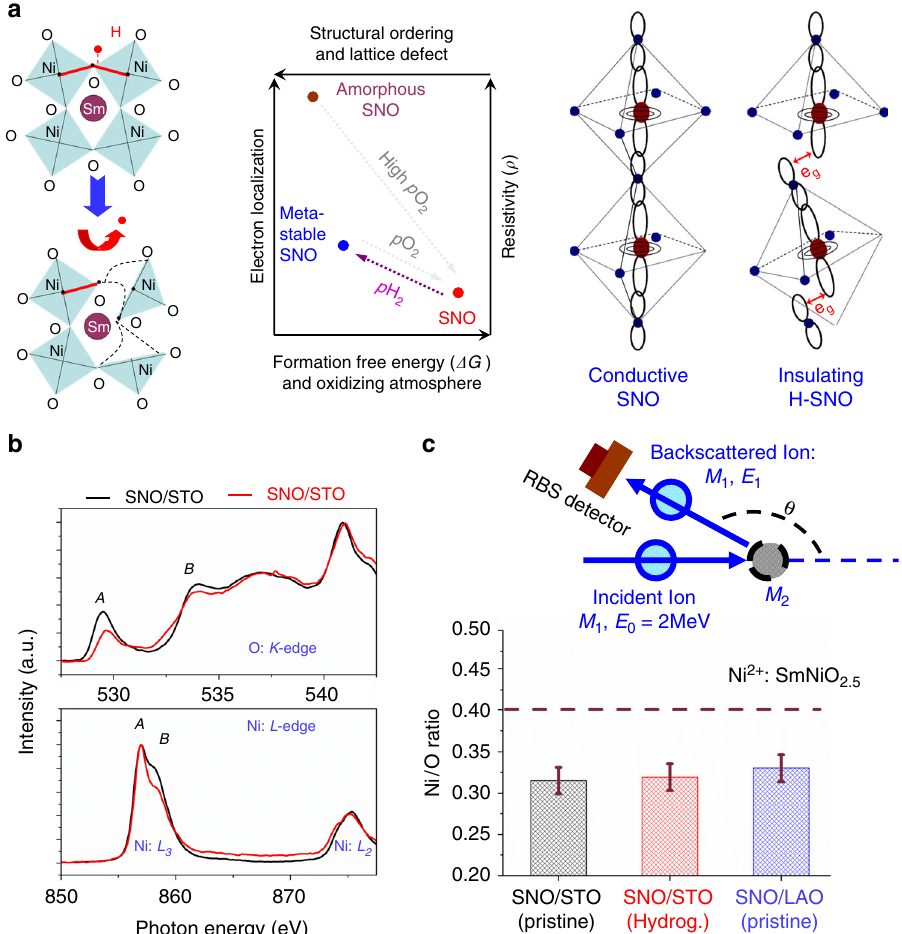
Fig. 4 Transient state in proton regulation of SmNiO 3 . a Illustrating the transition from the electron itinerant state to highly electron localized state triggered by the transient process during hydrogen diffusion, instead of the physical presence of the hydrogen composition. The structural disordering owing to lattice distortions results in the opening in band gap. b Near edge X-ray absorption fi ne structure (NEXAFS) analysis for SmNiO 3 /SrTiO 3 (red line) and SmNiO 3 /LaAlO 3 (black line). c Ratios of the Ni/O composition measured for SmNiO 3 /SrTiO 3 , hydrogenated SmNiO 3 /SrTiO 3 , and SmNiO 3 /LaAlO 3 by using the Rutherford backscattering (RBS). The upper scheme illustrates the RBS